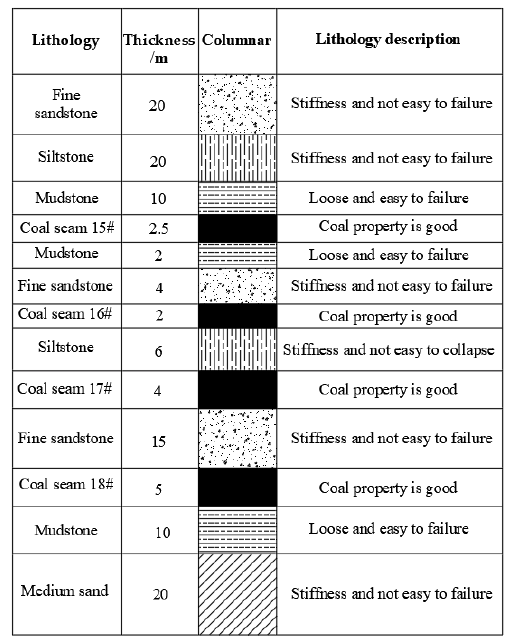
Figure 1. Vertical section of coal seams.